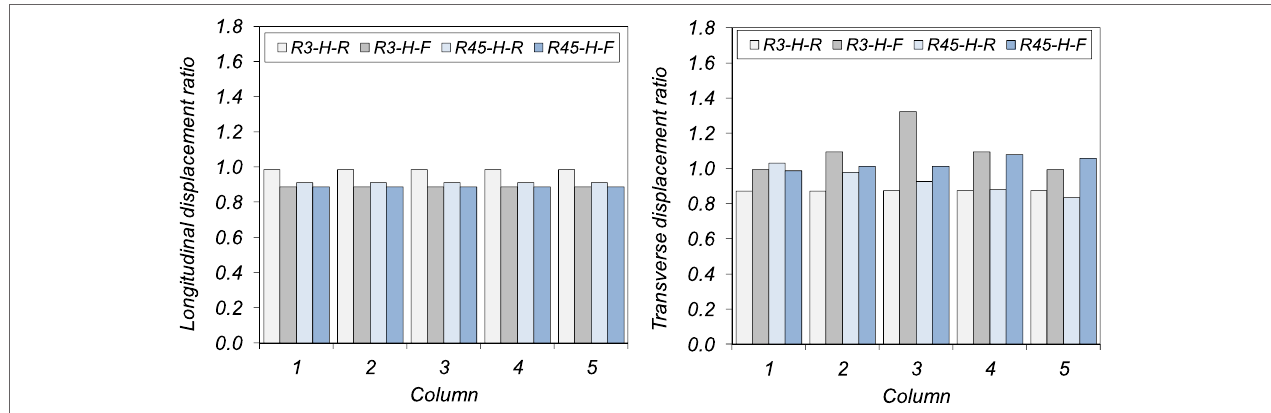
FigUre 12 | Column tip displacement ratio between the case study with the hoist mass and without it. The column number refers to Figure 11a . The reference R3 values are 195 (234) mm for all the columns in the longitudinal direction for the flexible (rigid) roof, and 106 (145) mm, 151 (145) mm, 140 (145) mm, 151 (145) mm, and 106 (145) mm for each column (1–5) in the transverse direction for the flexible (rigid) roof. The reference R45 values are 172 (294) mm for all the columns in the longitudinal direction for the flexible (rigid) roof, and 105 (171) mm, 162 (134) mm, 162 (98) mm, 83 (72) mm, and 82 (77) mm for each column in the transverse direction for the flexible (rigid)